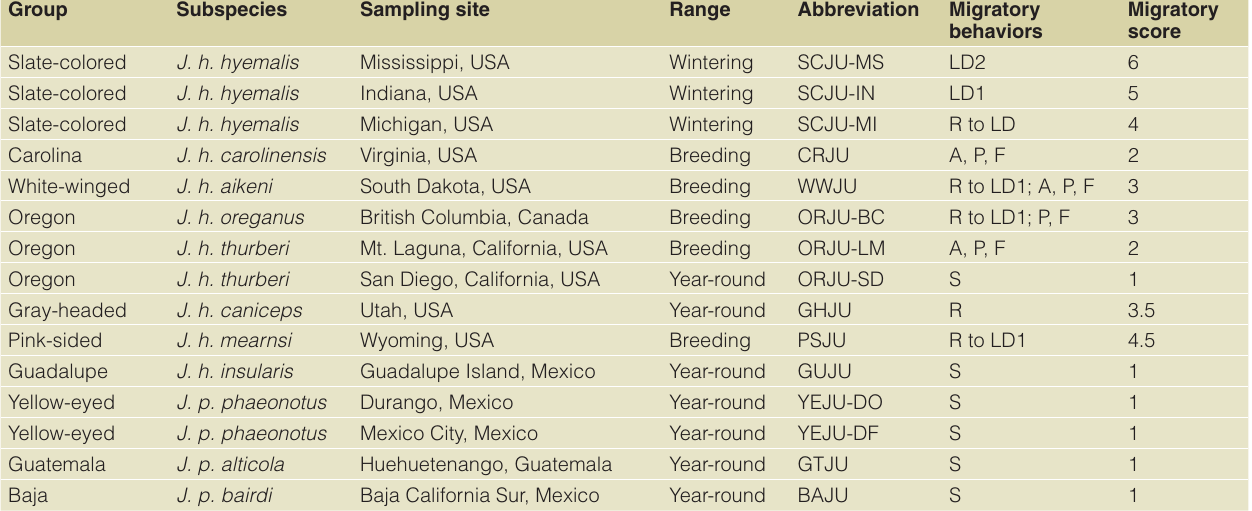
Table 1. Sampled populations and assigned migratory scores. Group categories follow generally from distinct groups of subspecies or unique forms as discussed by Milá et al. (2007) 36 or Nolan et al. (2002) 34 . Subspecies designations follow Miller (1941) 35 as summarized by Nolan et al. (2002) 34 and Sullivan et al. (1999) 33 ; dark-eyed subspecies are noted as J. h. spp. and yellow-eyed subspecies as J. p. spp. Migratory Behavior codes indicate the range of migratory behaviors inferred from breeding and wintering distributions, as follows: LD2 = long distance II, at minimum 1600 km up to 5600 km, depending on migratory connectivity; LD1 = long distance I, likely 400–700 km, possibly up to 5000 km, depending on migratory connectivity; R = regional, typically greater than 200 km; A = altitudinal, typically less than 200 km; P = apparent partial migration documented; F = apparent facultative migration documented; S = sedentary (see text for references). Migratory score ordinally ranks population migratory propensity, similar to previous published accounts 24